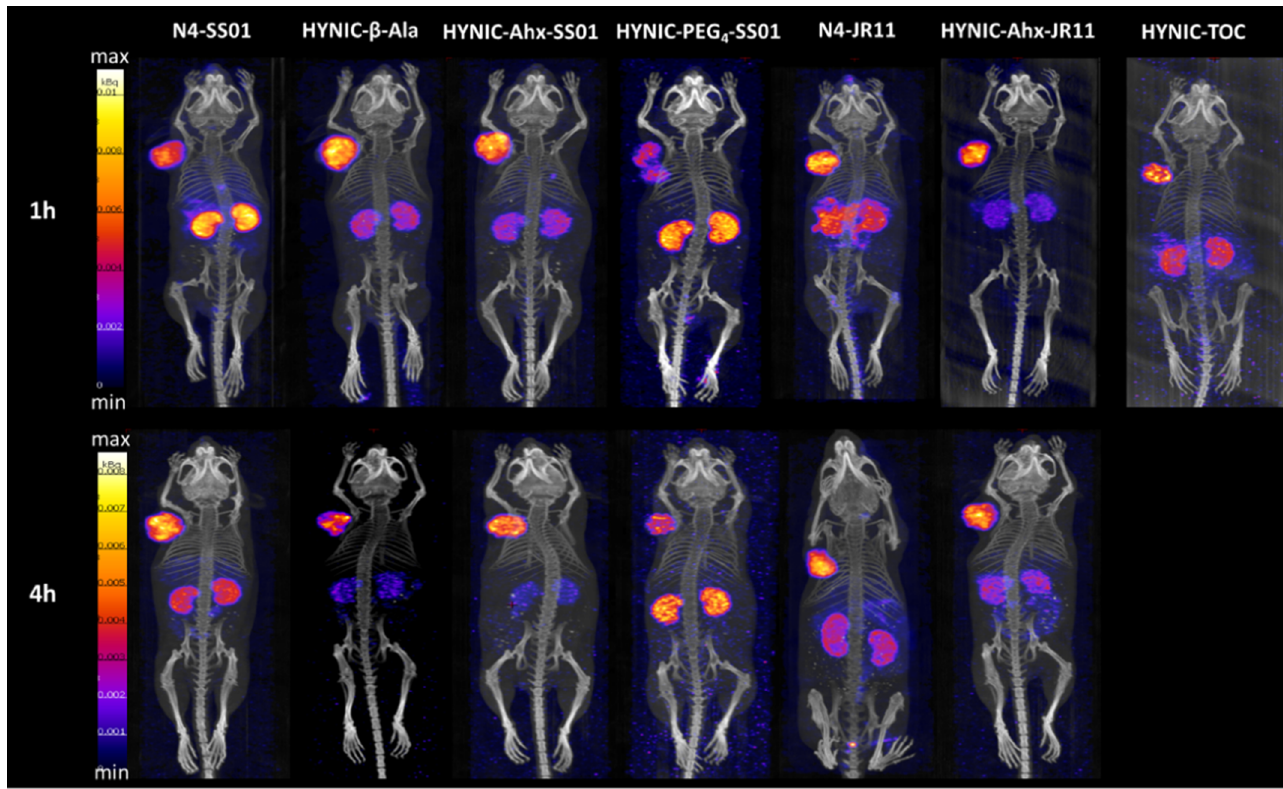
Figure 5. SPECT/CT images of all [ 99m Tc]Tc-labeled conjugates at 1 and 4 h p.i. The mice bearing HEK-SST2 tumors were intravenously injected with 100 µL/200 pmol/ 4–6 MBq of the indicated 99m Tc-labeled conjugate and were euthanized 1 or 4 h p.i. by keeping them in a CO 2 chamber for 2 min, followed by a slow increase in the concentration of CO 2 gas.